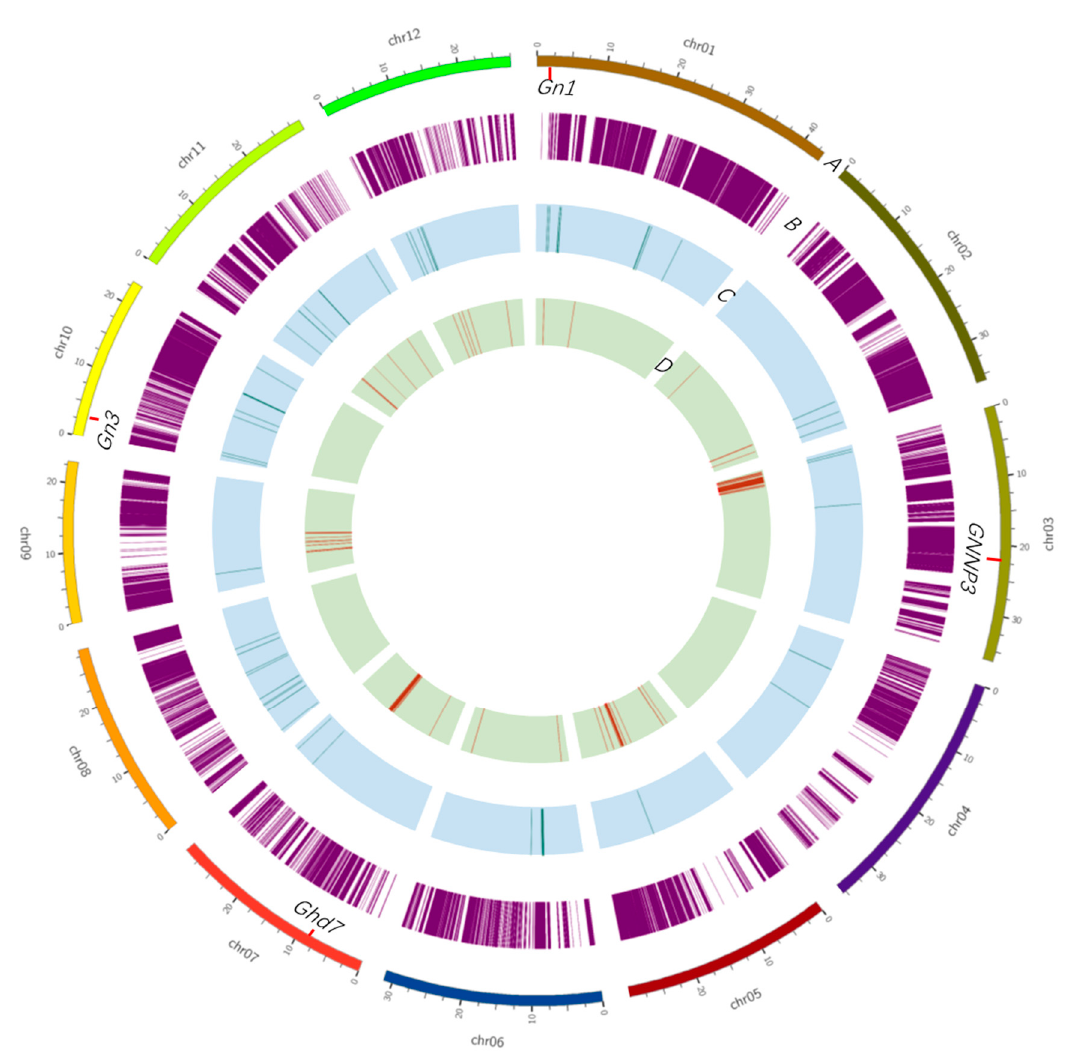
Figure 6. Overview of the subspecies-specific SNPs and introgression in Sasanishiki and Habataki. Tracks from the outer to inner circles indicate the following. ( A ) The chromosome length. The loci of grain number per panicle are indicated on the inside of the circle. ( B ) The distribution of 81,690 subspecies-specific SNPs in the genome. ( C ) The introgression of japonica -type SNPs into the genome of Habataki. ( D ) The introgression of indica -type SNPs in the genome of Sasnishiki.